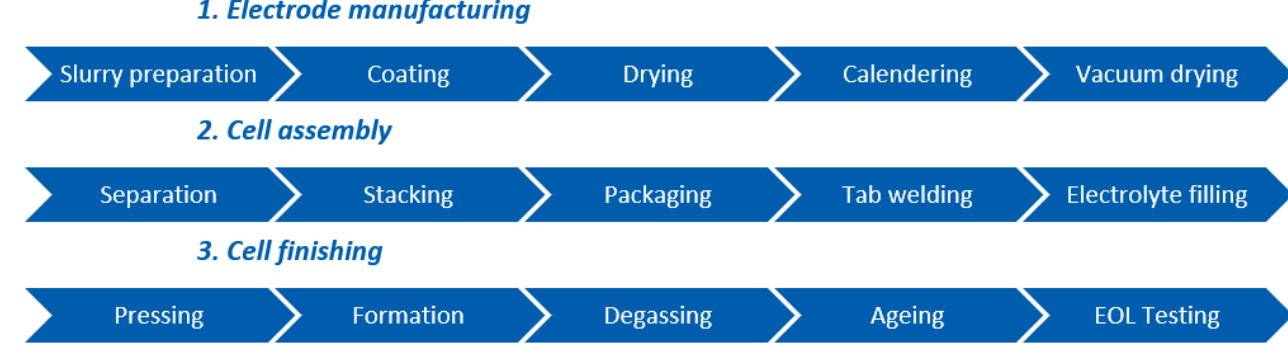
Figure 7. Process chain of conventional pouch cell production.